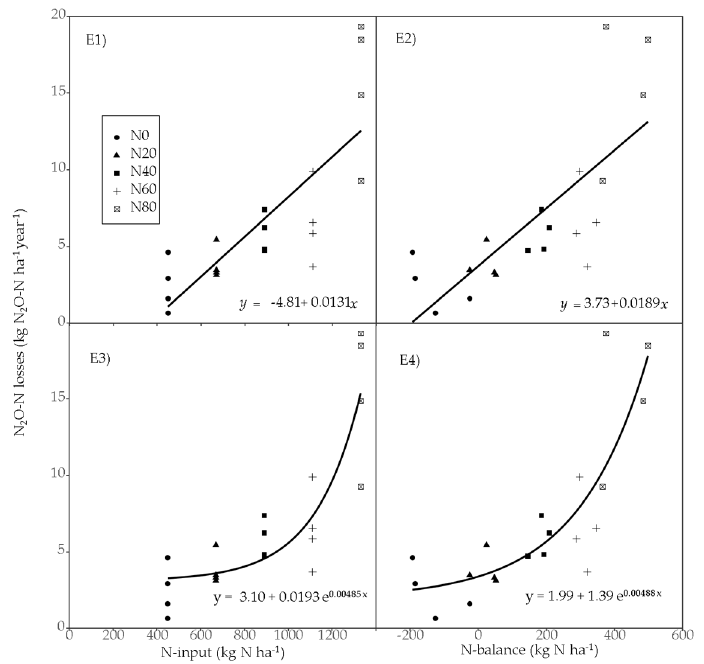
Figure 4. The linear relationship between accumulated N 2 O-N losses (kg N 2 O-N ha − 1 year − 1 ) in relation to ( E1 ) increased levels of N-input (kg N ha − 1 year − 1 ) as well as ( E2 ) increased levels of N balance (kg N ha − 1 year − 1 ). The nonlinear relationship between accumulated N 2 O-N losses (kg N 2 O-N ha − 1 year − 1 ) in relation to ( E3 ) increased levels of N-input (kg N ha − 1 year − 1 ) as well as ( E4 ) increased levels of N Table 4. The predicted annual N 2 O emissions based on the Intergovernmental Panel on Climate Change (IPCC) emission factors (EFs) (IPCC min + IPCC min + exc ). The EFs are calculated based